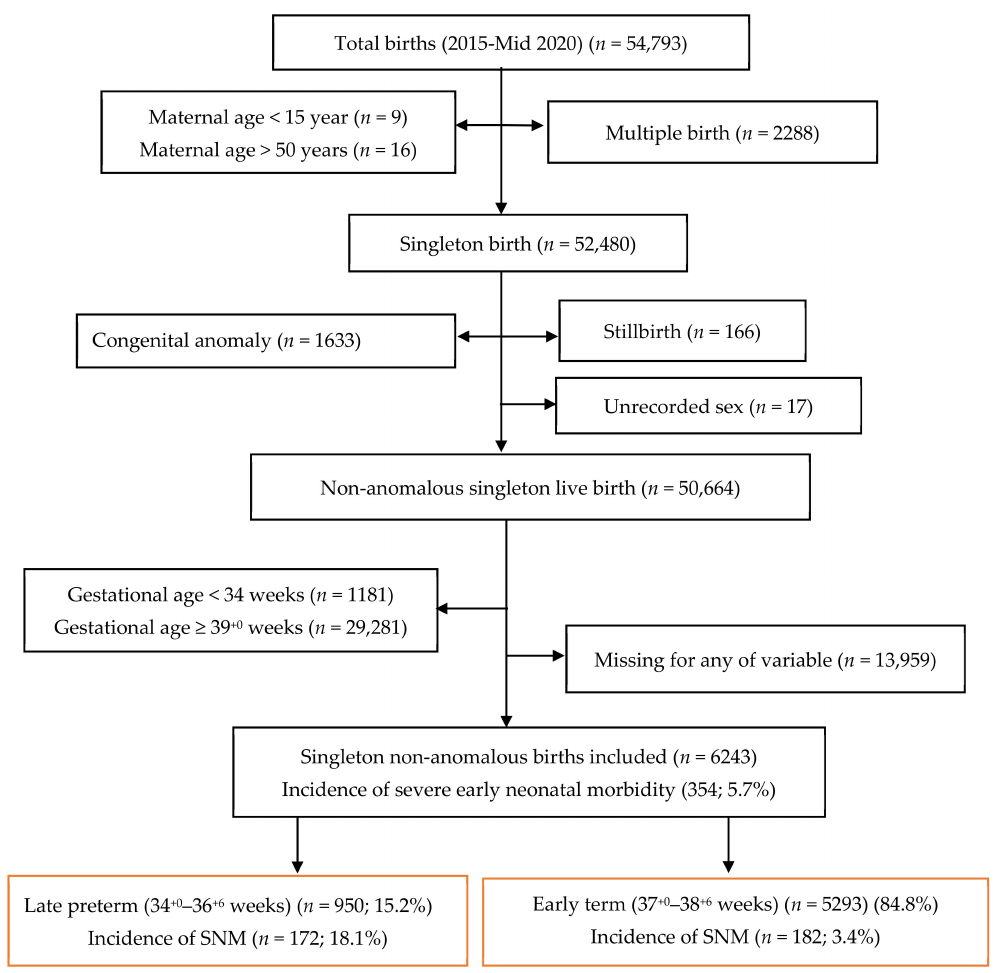
Figure 1. Participant selection flow